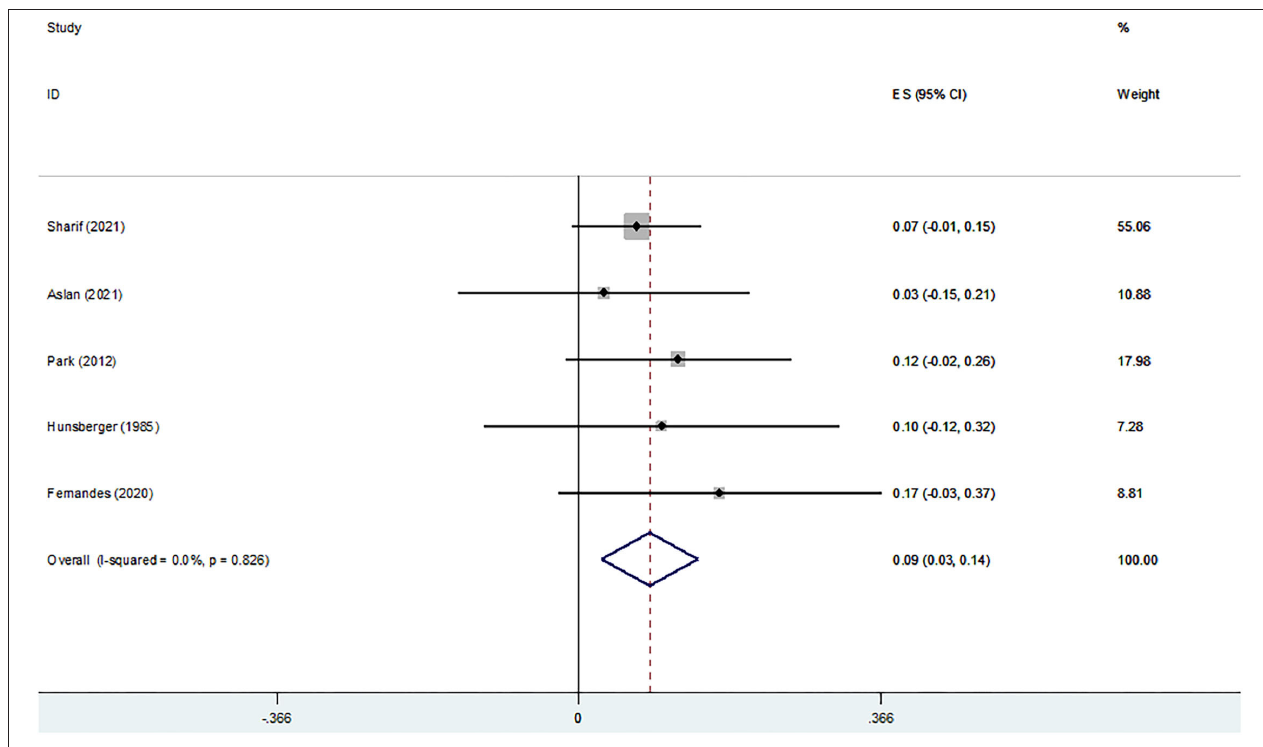
FIGURE 6 | Z-scores for life